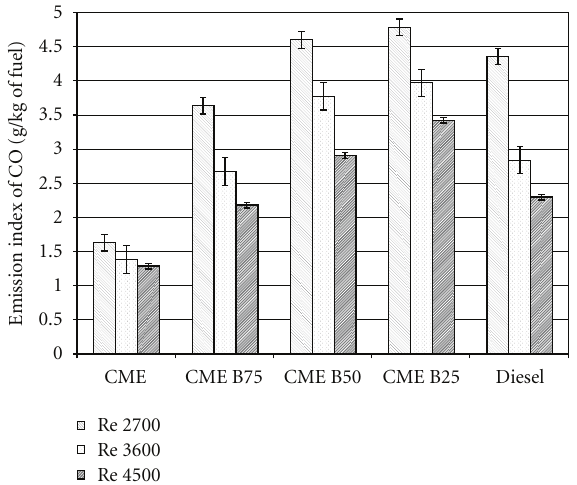
Figure 8: Comparison of CO emission index of various flames.